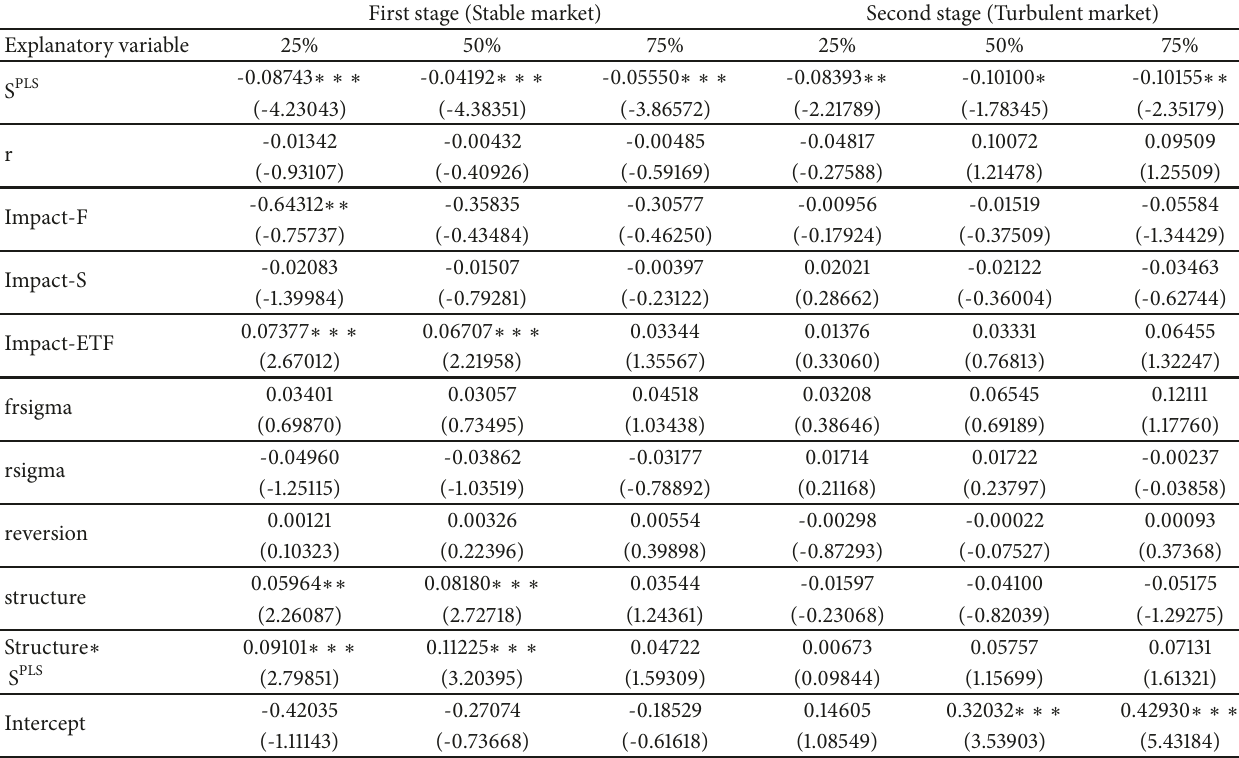
Table 3: Result of the regression estimation considering investors’